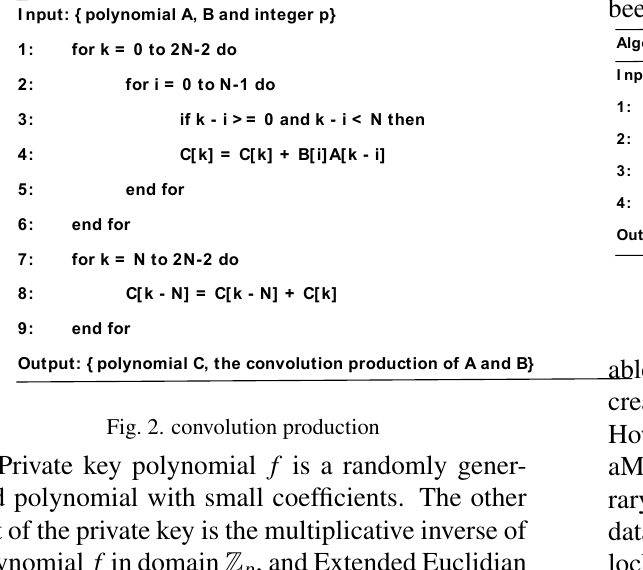
Fig. 2. convolution production